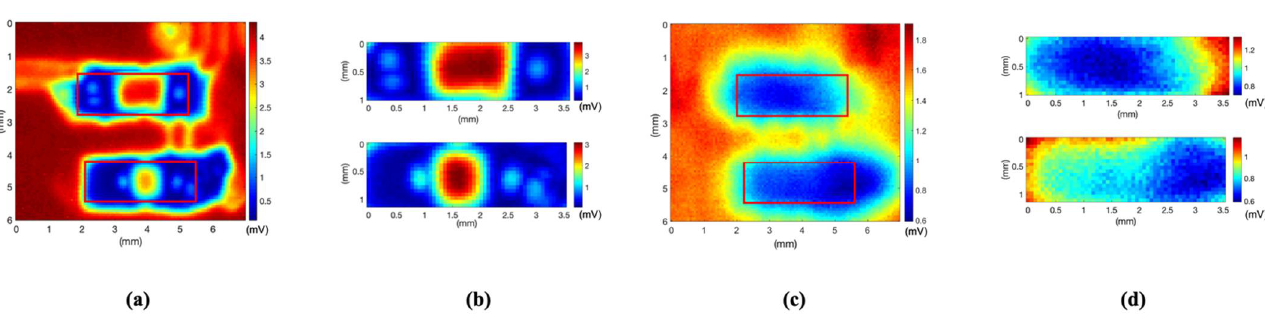
Figure 9. ( a ) C-mode image of transducer pulse–echo, ( b ) partial image of red rectangle area in transducer pulse–echo image, ( c ) C-mode image of the transmitted signal using a hydrophone, and ( d ) partial image of red rectangle area in hydrophone test.